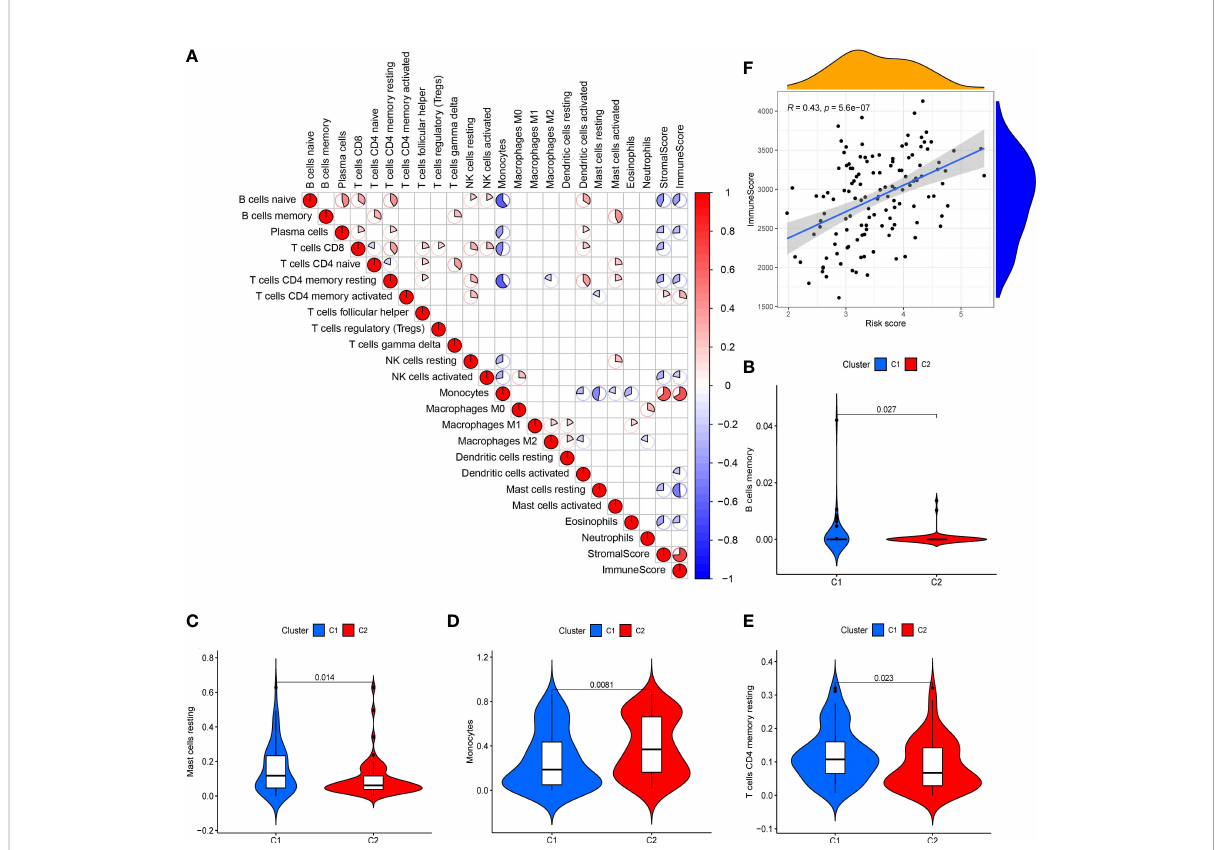
FIGURE 8 Analysis of tumor microenvironment in 10-gene signature (A) Correlation plots of 18 immune-related cells (derived from CIBERSOFT algorithms), stromal scores and immune score (derived from ESTIMATE algorithms) in AML (red: positive correlation; blue: negative correlation; p < 0.05). (B-E) Violin diagrams of 4 immune-related cells (B cells memory, Monocytes, T cells CD4 memory and Mast cells). (F) Scatter plot of the correlation between immune score and the riskscore in the 10-gene